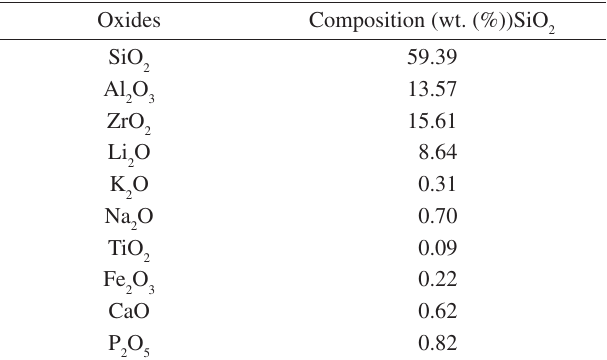
Figure 2. Powder particle size distribution of the glass.